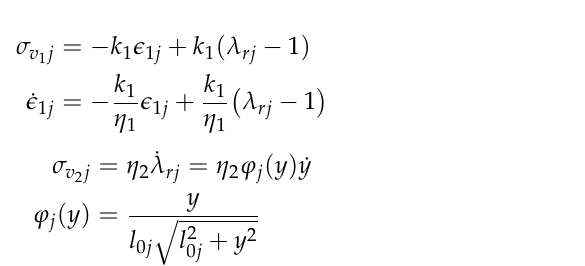
Figure 3. The composition of two material models and their placement in the elliptical